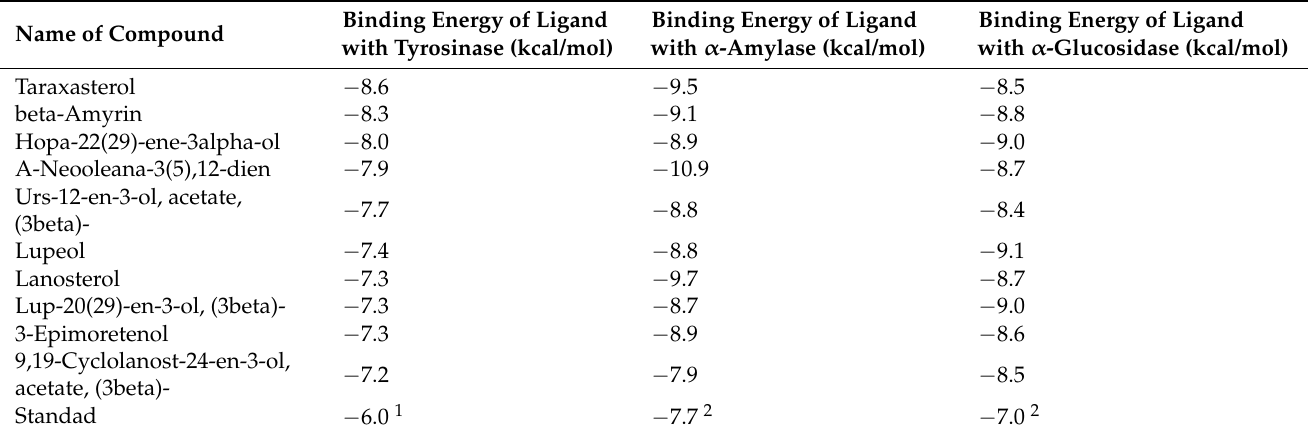
Table 8. Binding energies of docked compounds against tyrosinase, α -amylase, and α